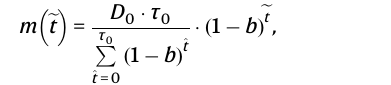
Supplementary Fig. 6. The elasticity design instead results in vehicle lifetimes that approach zero for very high driving intensities.